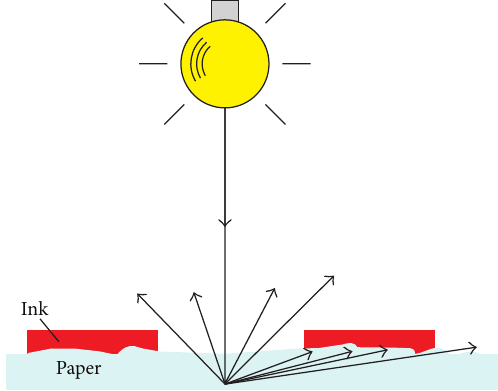
Figure 1: Light gathering in the area of the inked paper